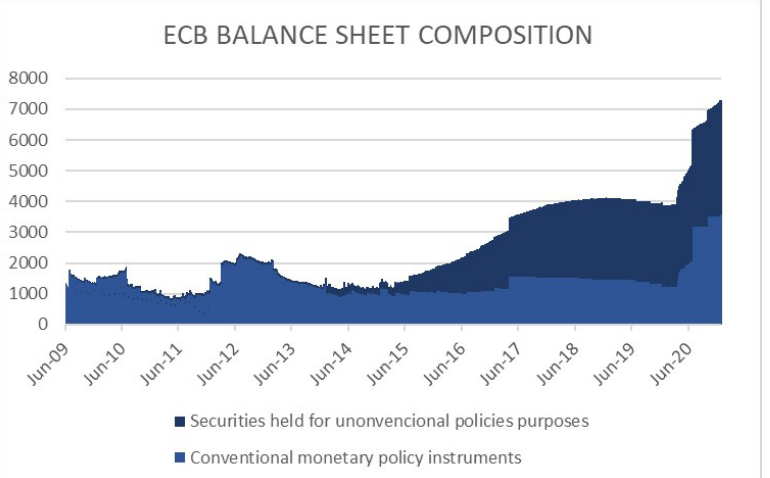
Figure 2. ECB’s Balance Sheet composition (millions of Euro). Sample period: 1 June 2009–31